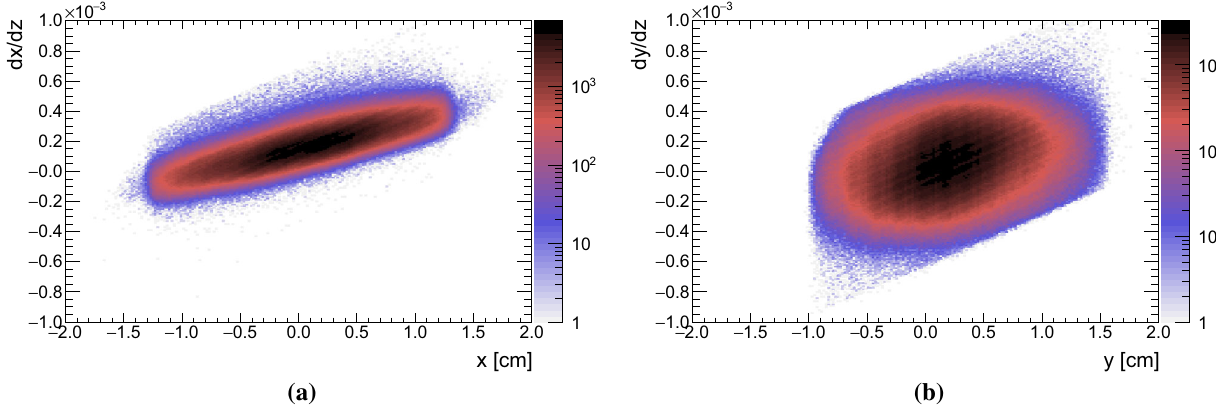
Fig. 15 Beam slope d x / d z vs. x position ( a ) and d y / d z vs. y ( b ) for beam particles selected by the T 2 trigger. The distributions are used to randomly generate beam particles in the NA61/SHINE Monte Carlo